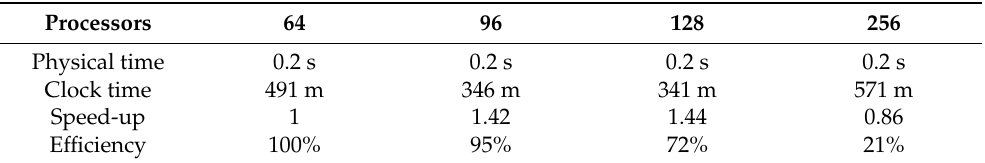
Table 3. Efficiency of OpenFOAM parallelization for a test case of the CPF at headwind condition with 28.5 million cells.